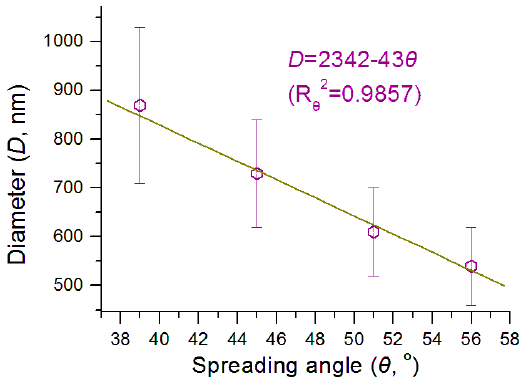
Figure 9. The interrelation between the spreading angle of the instable region and the fibers’ diameter.